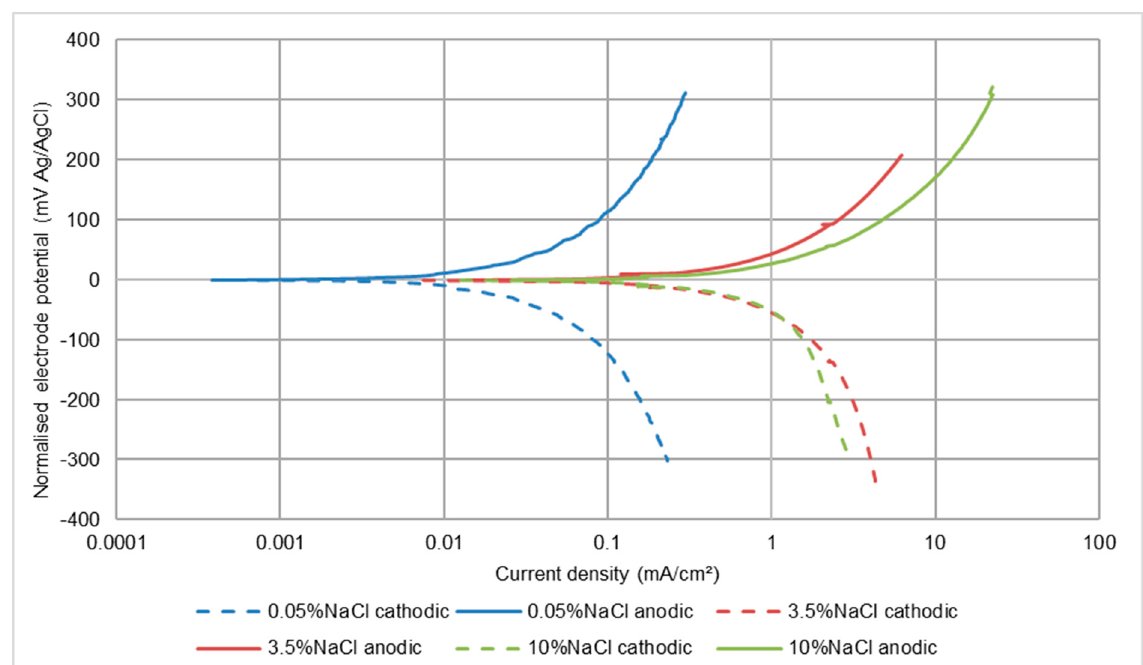
Figure 11. Polarisation plots for UNS G43400 steel in SLEC conditions. Table 6. Corrosion rates of UNS G43400 low-alloy steel in the different hydrodynamic conditions. Static LEC wt% I corr (mA/cm 2 ) NaCl Measured